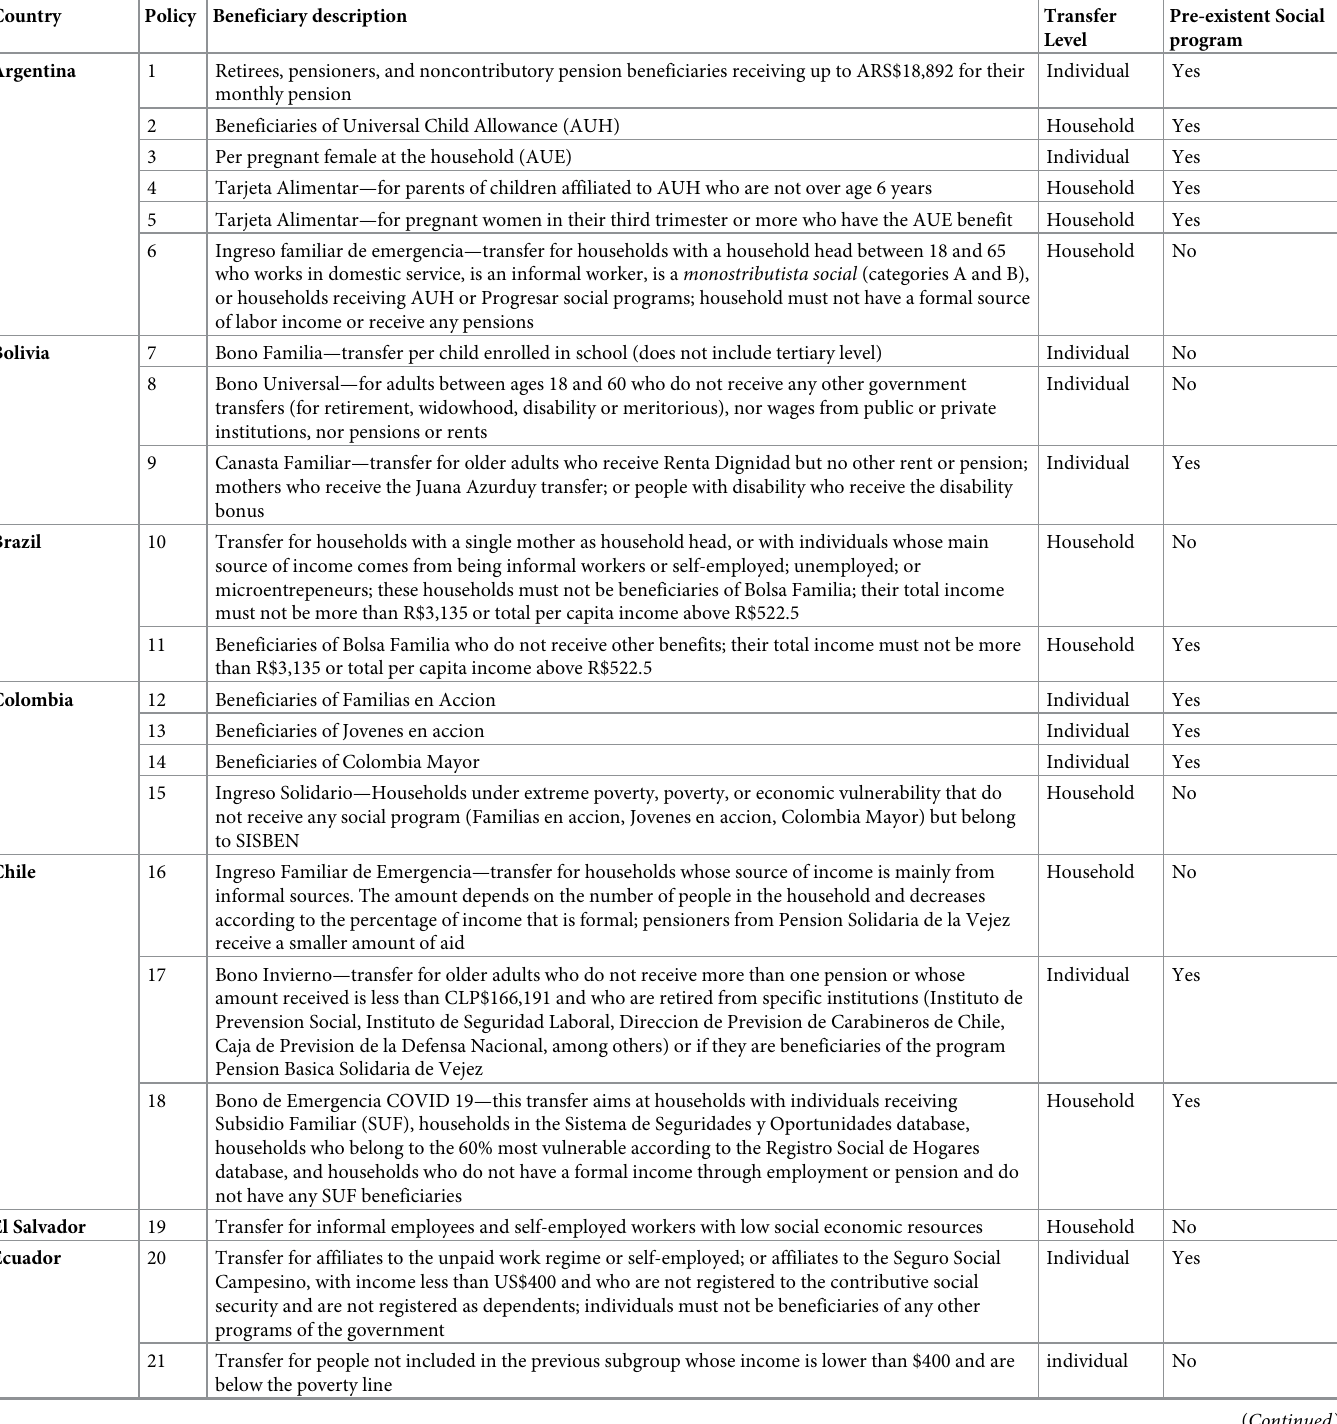
Table 2. Emergency social assistance